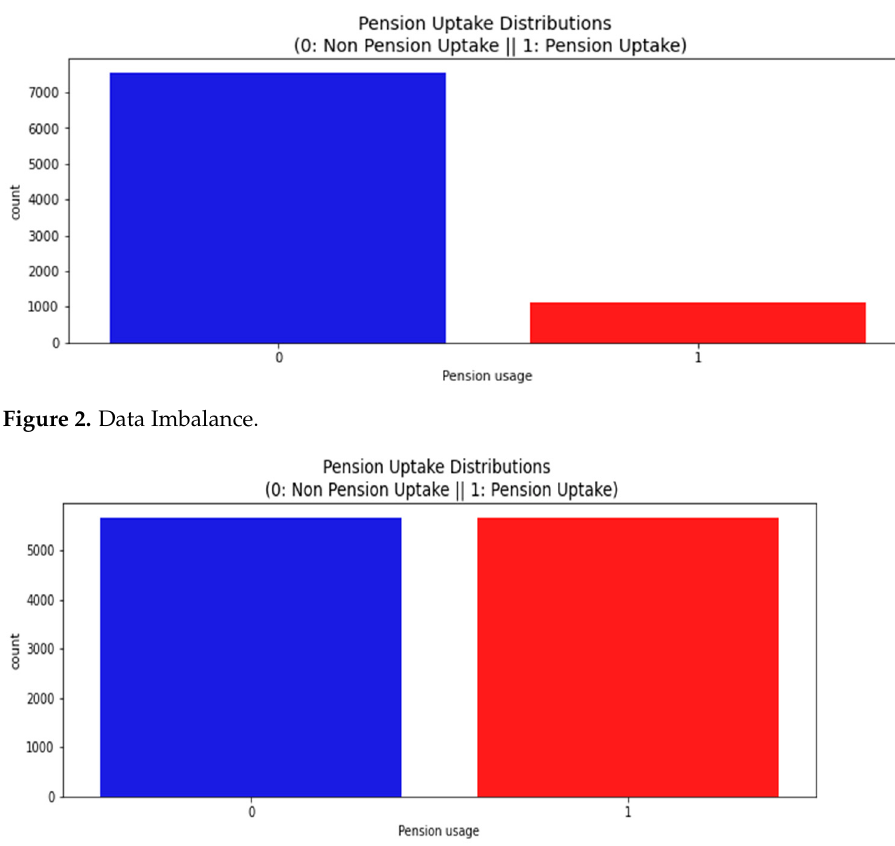
Figure 3. Class balance after up-sampling of the data. 1